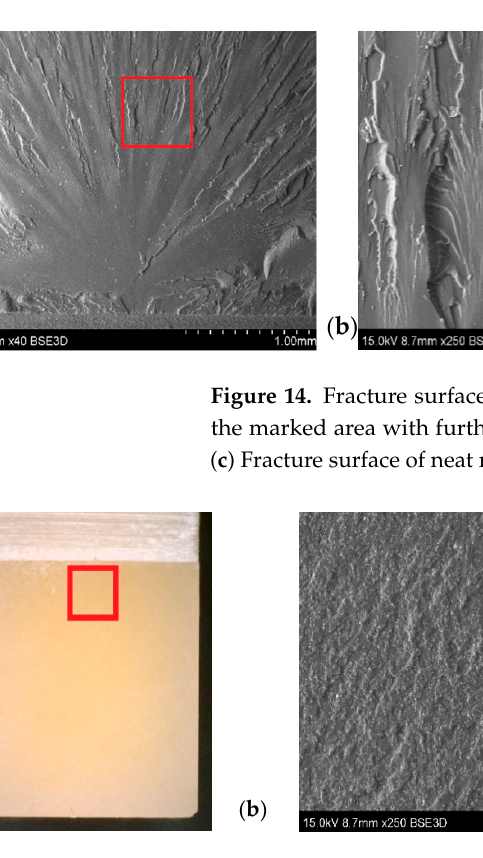
Figure 15. Fracture surface of resin with the addition of a filler 30 phr Al(OH) 3 , white points representing ATH filler. ( a ) Sample with marked SEM images location. ( b ) Fracture surface with magnification ×250. ( c ) Fracture surface with magnification ×500.